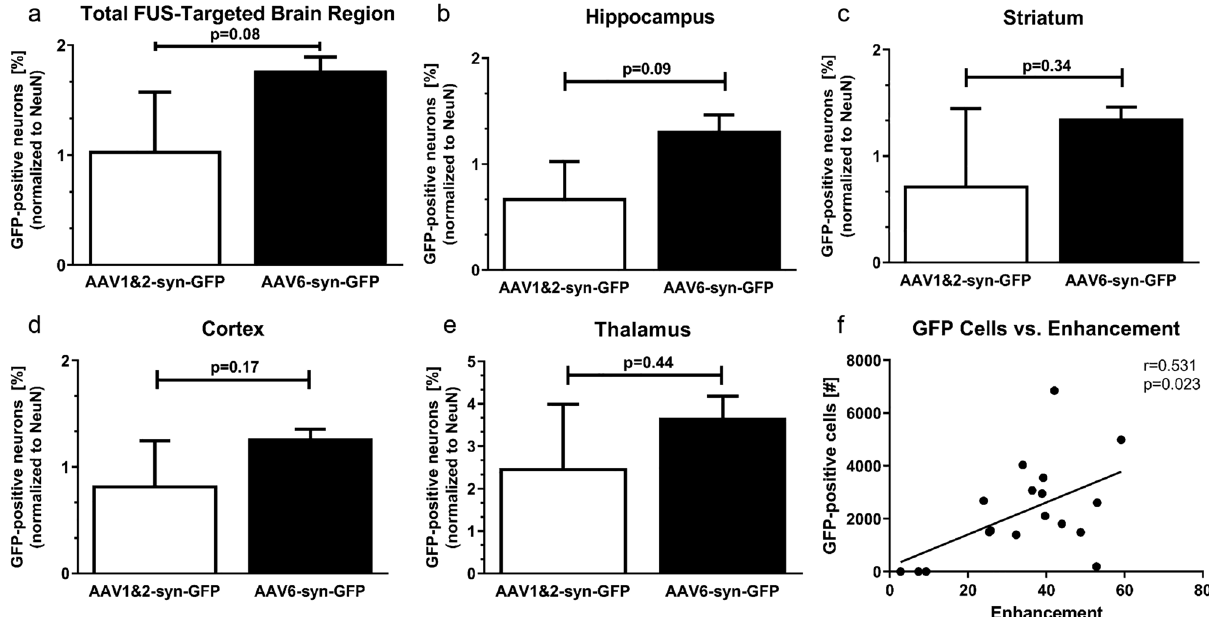
Figure 4. Quantification of neuronal transgene expression following MRIgFUS delivery of AAV1&2 and AAV6 to the brain. Focused ultrasound (FUS) delivery of AAV6-syn-GFP did not result in a statistically significant increase in percentage of GFP-positive neurons compared to AAV1&2-syn-GFP in the total GFP-positive region of the brain ( p = 0.08) ( a ) and hippocampus ( p = 0.09) ( b ) . There was also no significant difference in percentage of GFP-positive neurons in the striatum ( p = 0.34) ( c ), cortex ( p = 0.17) ( d ), or thalamus ( p = 0.44) ( e ). Data is represented as the mean ± SEM, percent of co-labelled GFP and neuronal nuclei antigen (NeuN)-positive cells from the total NeuN-positive population. For quantification, 3 distinct, non-overlapping FUS focal spots per animal were averaged for each reported percentage, where n = 3 animals per group. An ANCOVA was used to isolate the effect of serotype on percentage of GFP-positive cells since a weak (r = 0.531), but significant (* p = 0.023) correlation was found between the number of GFP-positive cells within the region of FUS application and MRI enhancement (n = 18 focal points) ( f ).